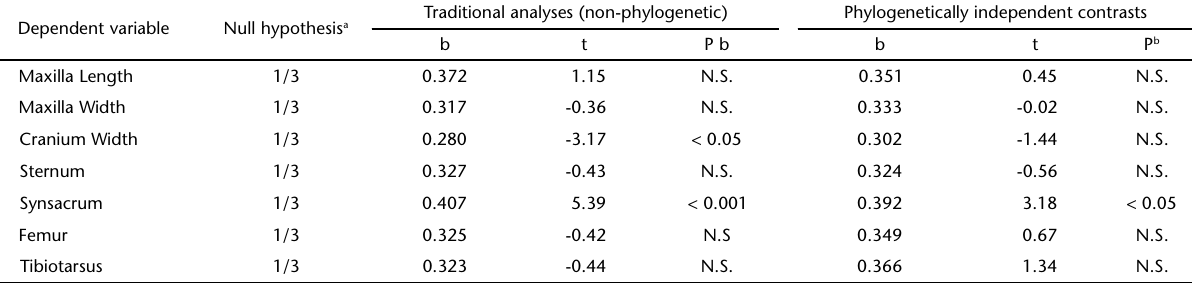
Table V. Allometric exponents (b) of regression of skeletal measures on body mass of 24 species of Bucerotidae in traditional analyses and phlogenetically independent contrasts. Dependent